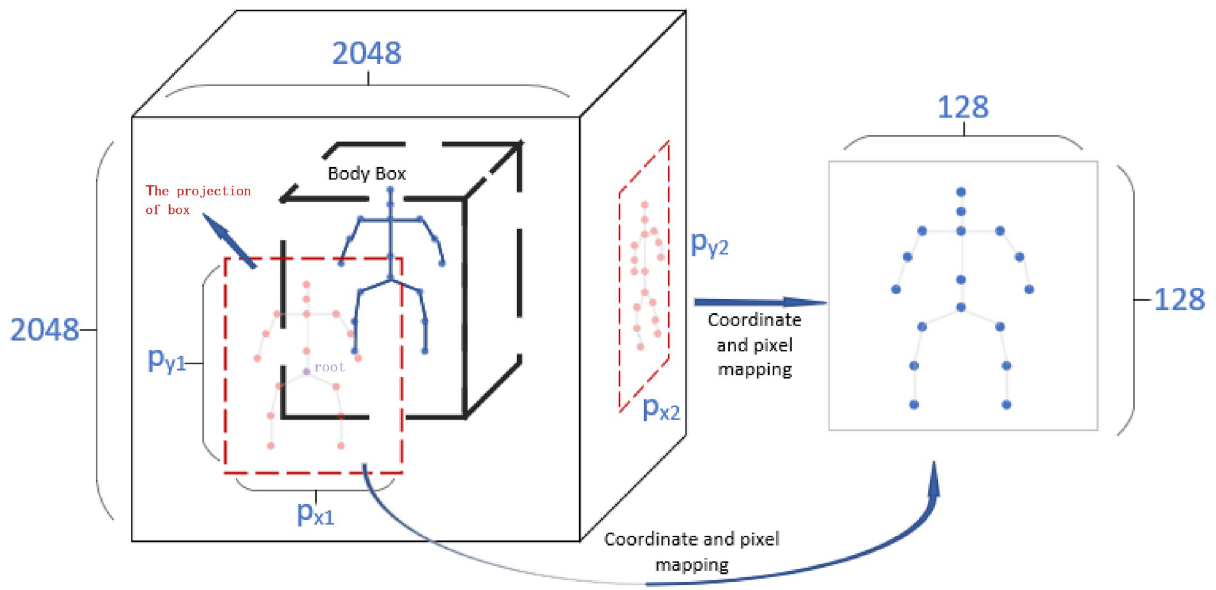
Fig 5. The projection of the 3D pose data in the four views is converted to four small images with a resolution of 128 � 128 (or 256 � 256) without losing their relevance and continuity.